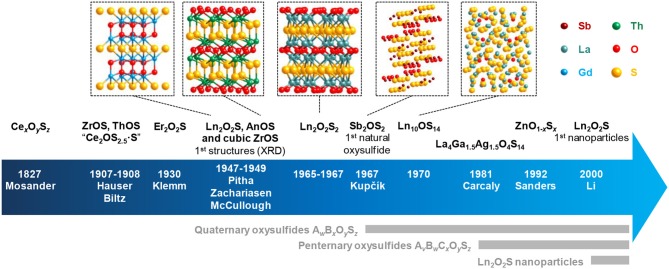
Key dates and authors of the oxysulfide research with some related structures. Ln stands for lanthanide and An for actinide. An2O2S compounds are also known since 1949 (Pu2O2S) and possess the same structure as Ln2O2S.